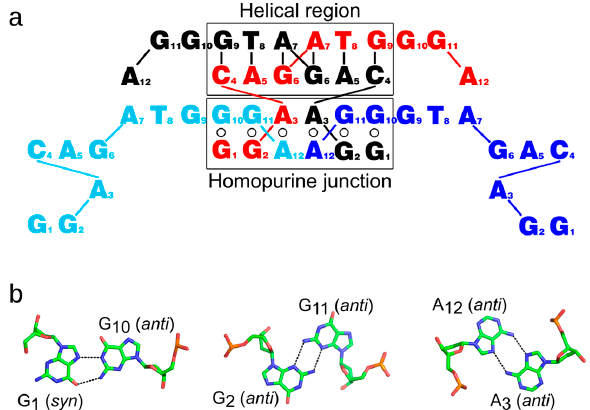
Figure 5. The DNA 13-mer lattice with non-canonical base pairs. ( a ) Secondary structure of base pairing interactions. Four identical strands are colored differently. Dashes indicate Watson-Crick base pairs, and circles indicate non-canonical base pairs. G 13 is disordered in the crystal structure and is not shown. ( b ) The three unique non-canonical base pairs of the homopurine junction. Black dashes indicate hydrogen bonding.